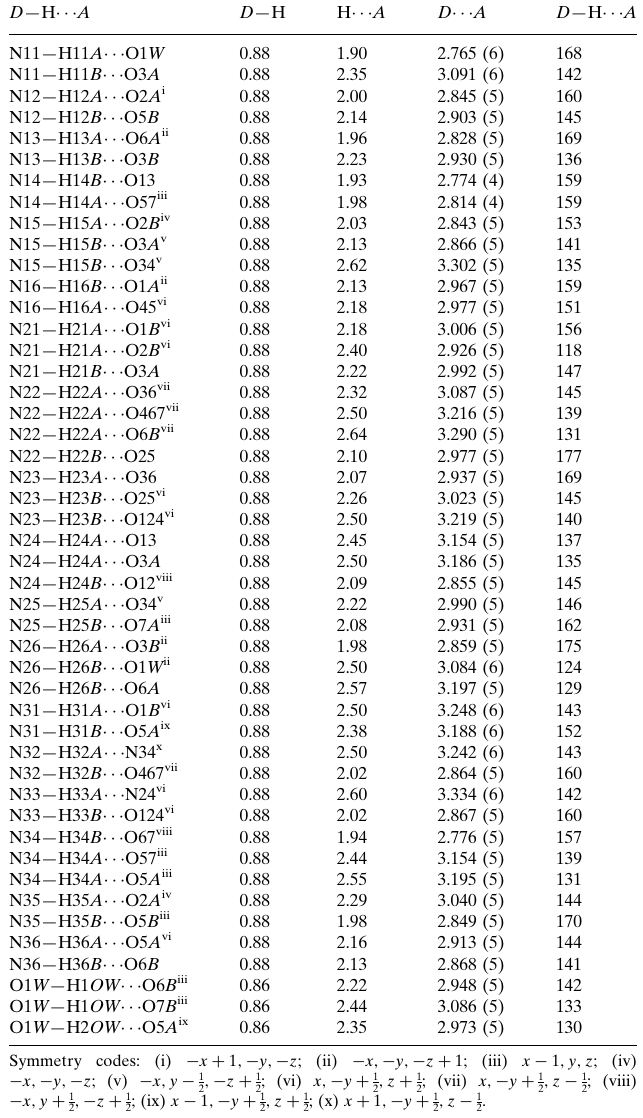
Experimental Crystal data